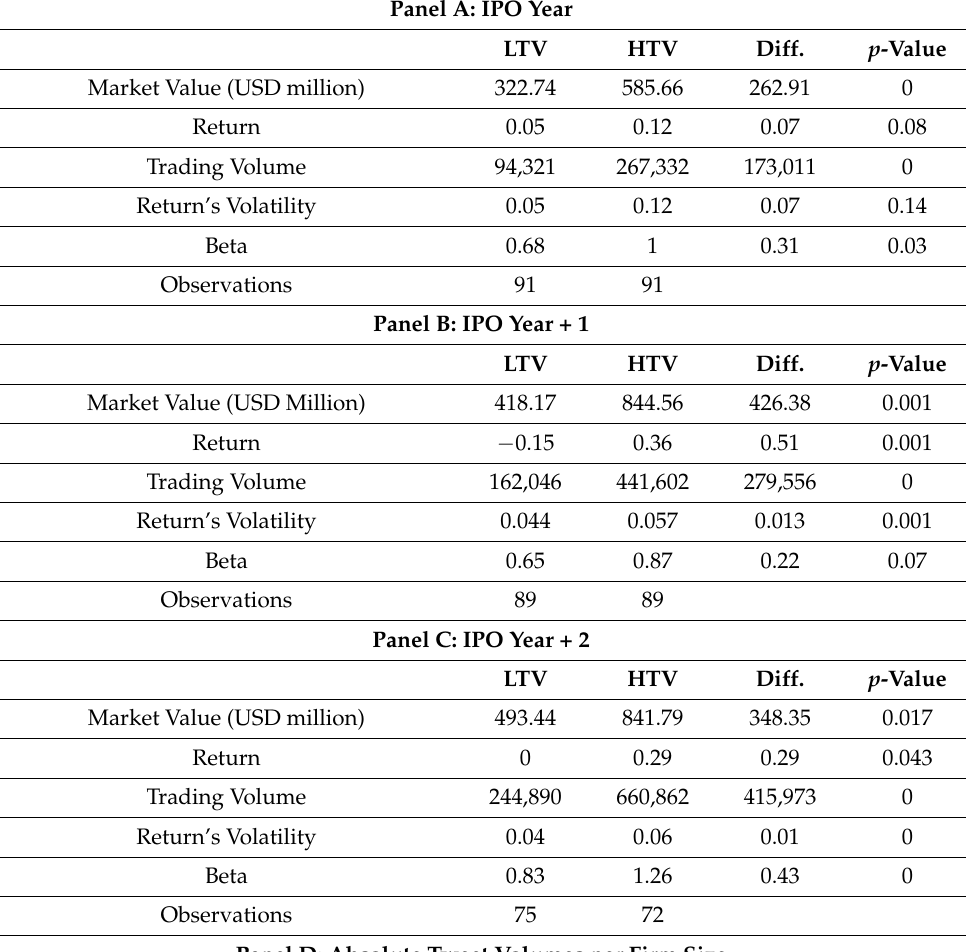
Table 5. Capital Market Variables: Descriptive Statistics for HTV and LTV Firms. Panel A: IPO